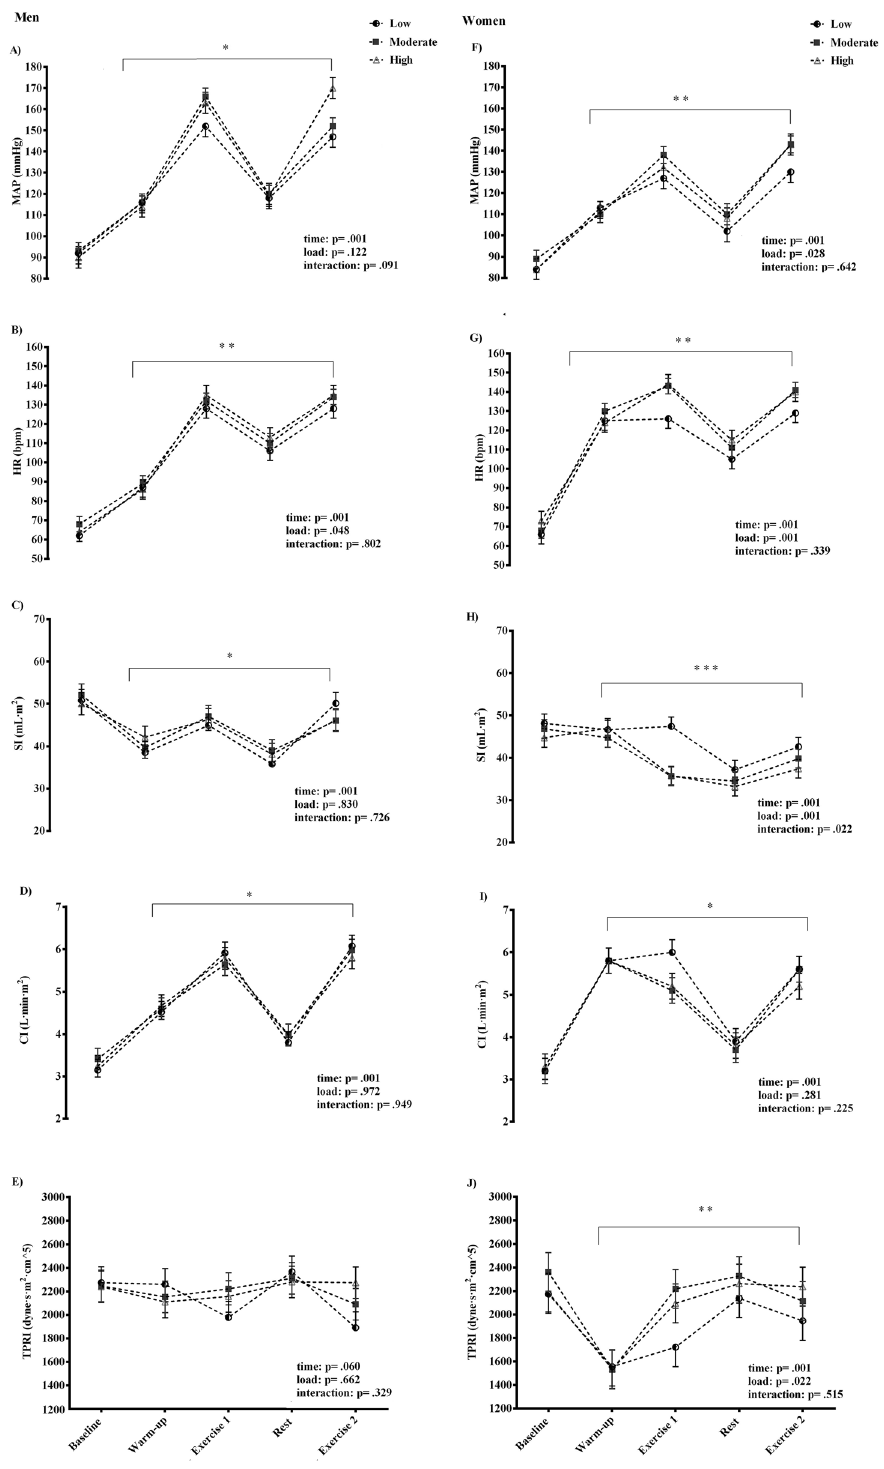
Figure 1. Cardiovascular response to the flywheel exercise. MAP mean arterial pressure, HR heart rate, SI stroke index, CI cardiac index, TPRI total peripheral resistance index. *Time effect. **Load effect. ***Interaction